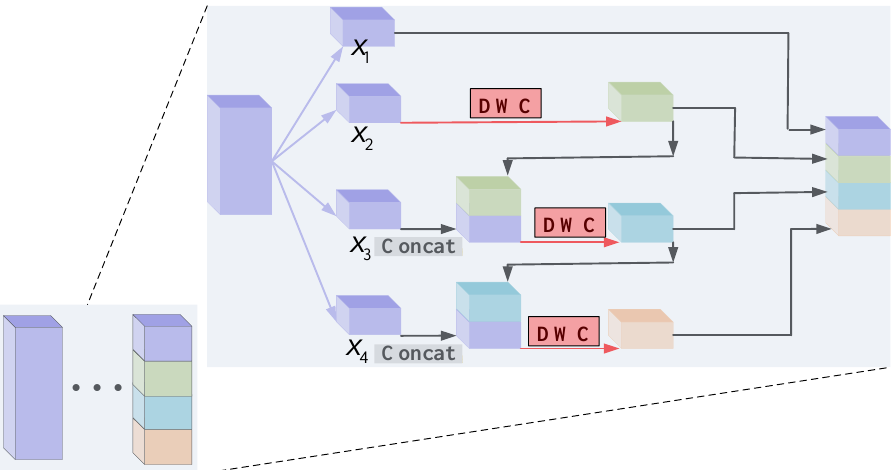
Remote Sens. 2022 , 13 , x FOR PEER REVIEW 11 of 29